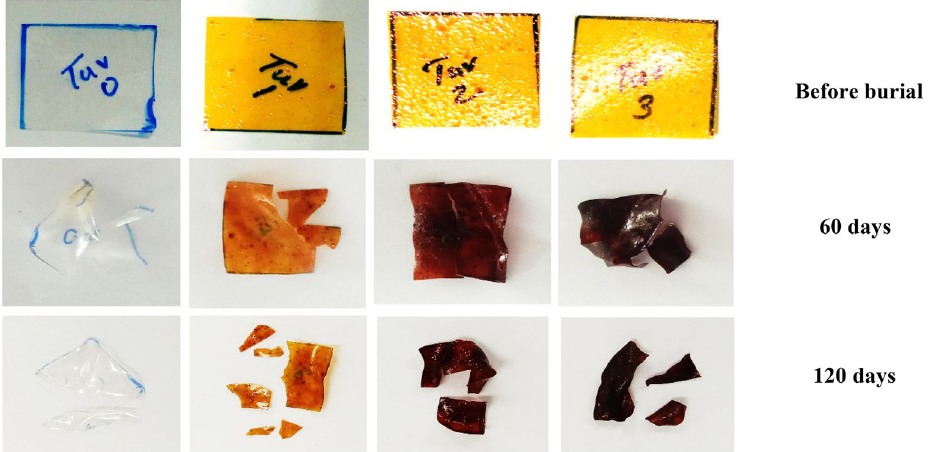
Figure 10. Images of soil biodegradability of PVA/CMC/TUR films at regular intervals.